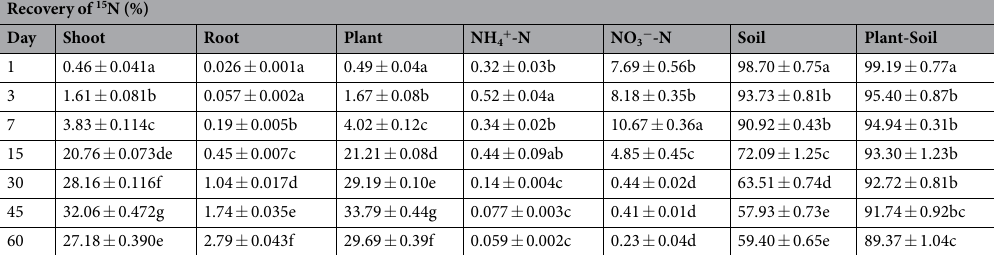
Table 3. Recovery of γ -PGA- 15 N in the nitrogen (N) pools of plant-soil system at different sampling days. Means followed by the different letters in the same column are significantly different (p = 0.05). Plant 15 N recovery was calculated as the sum of 15 N recovery in shoot and root, 15 N recovery of plant-soil was calculated as the sum of the 15 N recovery in plant and soil.